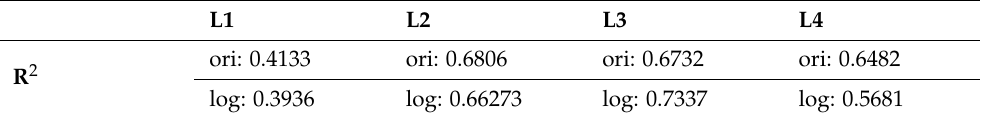
Figure 10. The Taylor diagram of different positions. ( a – d ) represent the results of L1, L2, L3, and L4. Table 1. Values of R 2 for the four points. ori indicates results using the original data as input, log indicates results using logarithmic data as input, and obs indicates the observed value.